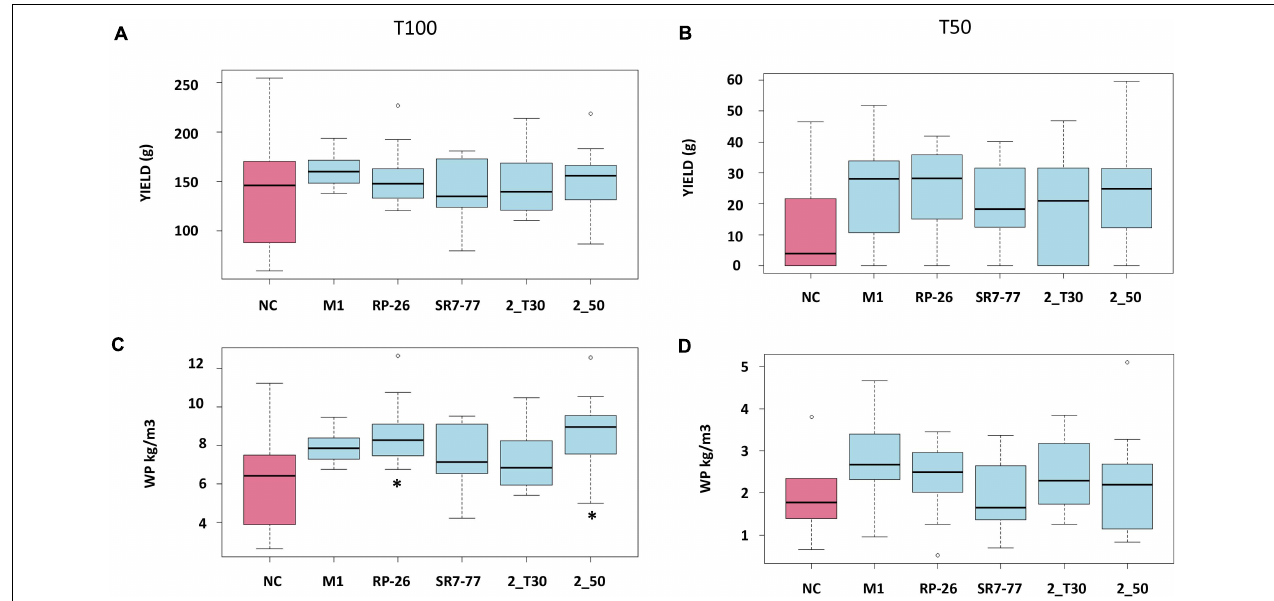
FIGURE 2 | Effect of PGP bacteria inoculation on (A,B) yield and (C,D) WP of tomato plants ( n = 10) under full irrigation condition (A,C) and water stress (B,D) . Red box indicates non-bacterized control plants (NC); blue boxes indicate plants bacterized with Micrococcus yunnanensis M1, Bacillus simplex RP-26, Pseudomonas